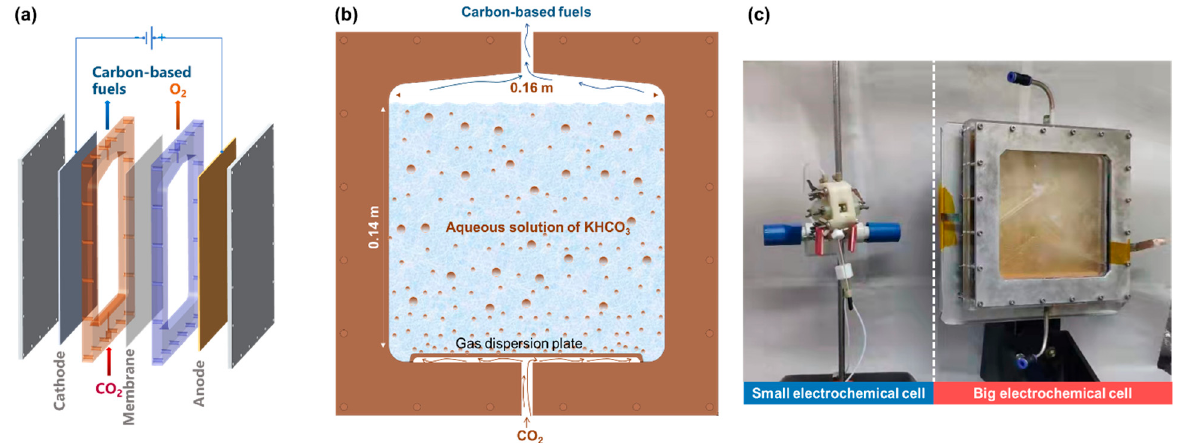
Figure 1. CO 2 R electrochemical cell. Schematic illustration of ( a ) the structure layout of the self-built big electrochemical cell and ( b ) catholyte chamber. ( c ) Optical image of the electrochemical cells used in this work. The small electrochemical cell is manufactured by a stereolithography 3D printer (Formlabs, form 2). The catholyte chamber and anolyte chamber of the big electrochemical cell are made of acrylic glass. The gas dispersion plate is a self-made sintered glass filter with a porosity of G4.